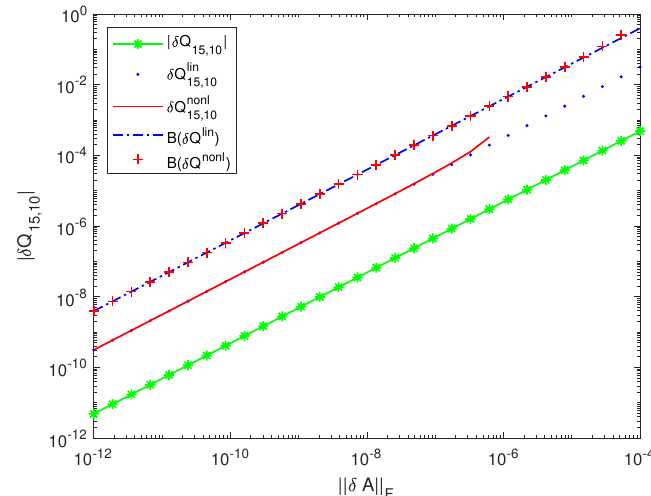
Figure 3. Exact values of δ Q 15,10 and its bounds as functions of the perturbation norm.